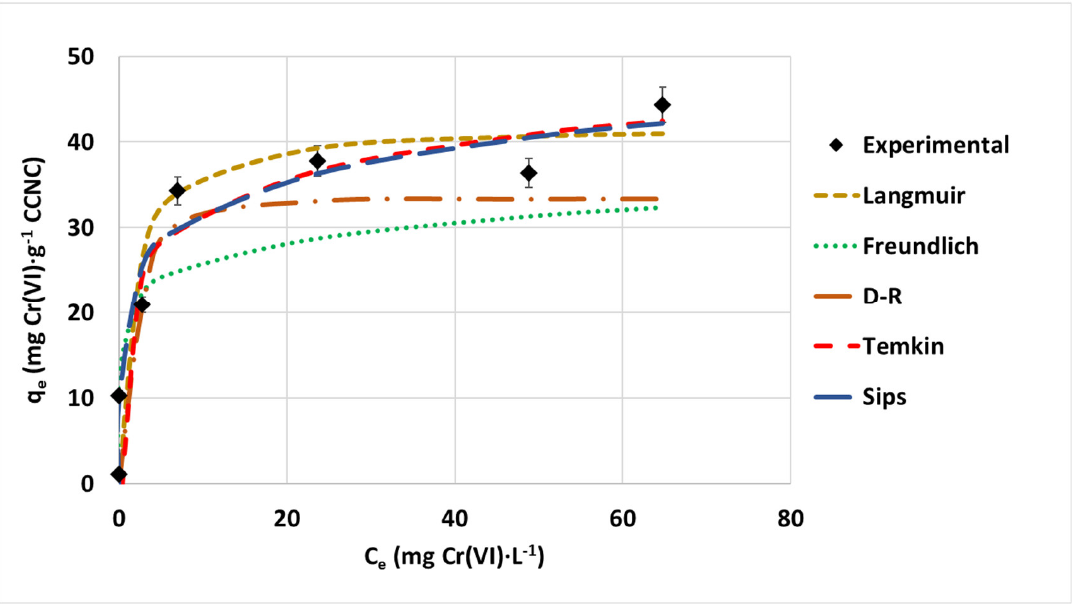
Figure 8. Isotherm experimental data of hexavalent chromium on CCNC and isotherm model adjustment of the Langmuir, Freundlich, Temkin, D-R and Sips equations. Table 1. Adjusted isotherm model parameters to hexavalent chromium adsorption onto CCNC experimental data.